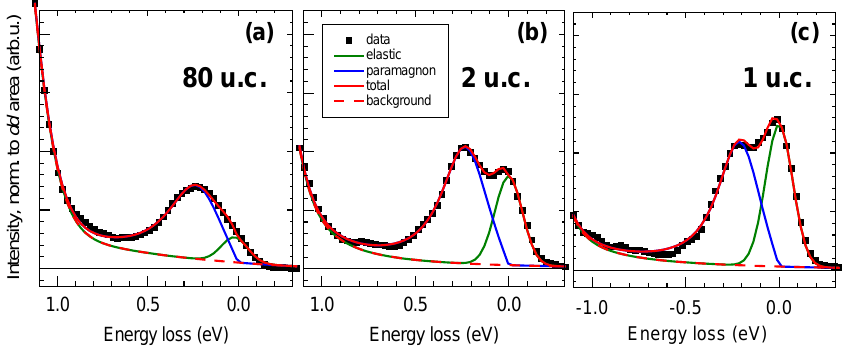
Figure 4. Panels ( a – c ): Fit to the RIXS spectra of 80, 2 and 1 u.c-thick NdBa 2 Cu 3 O 7 − x films at q (cid:107) = 0.376